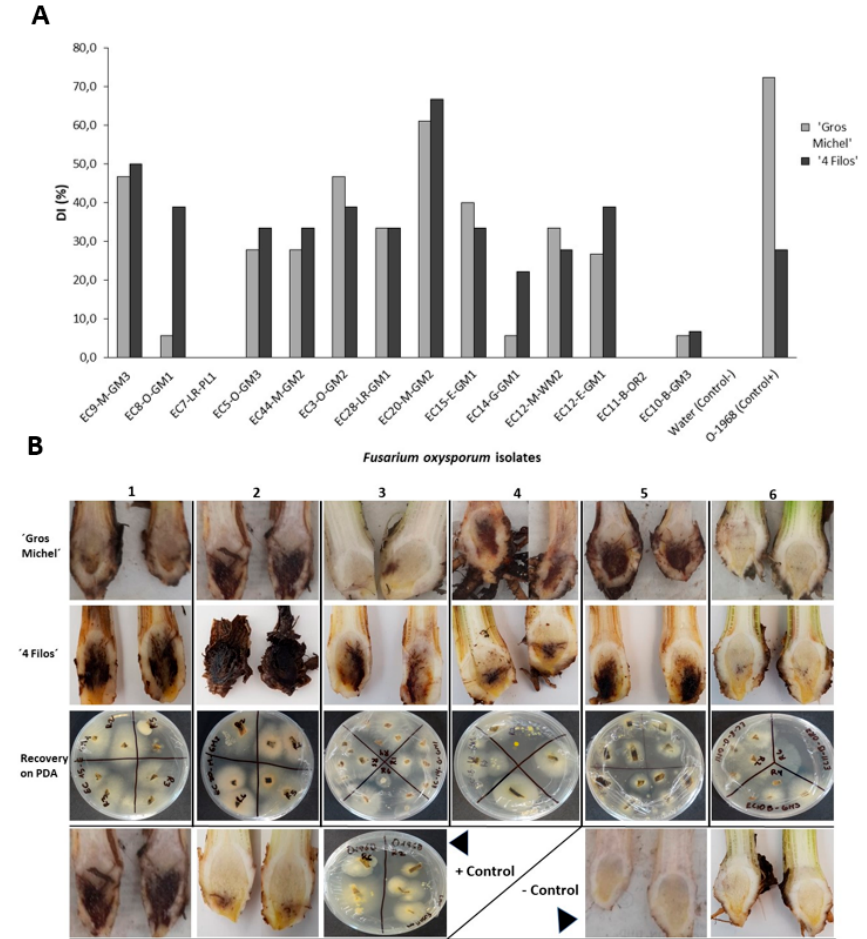
Figure 6. Di ff erential response of ‘Gros Michel’ and ‘4 Filos’ banana plants 45 days post-inoculation with Fusarium oxysporum isolates from Ecuador using corn-meal sand inoculation. ( A ) Disease index (DI) according to McKinney infection index [40]. ( B ) Internal symptoms of Fusarium wilt of banana (FWB) caused by six isolates representative of each province sampled inoculated on two banana cultivars: 1 = EC15-E-GM1, 2 = EC20-M-GM2, 3 = EC14-G-GM1, 4 = EC28-LR-GM1, 5 = EC3-O-GM2, 6 = EC10-B-GM3 and, recovering of F. oxysporum from rhizome-a ff ected